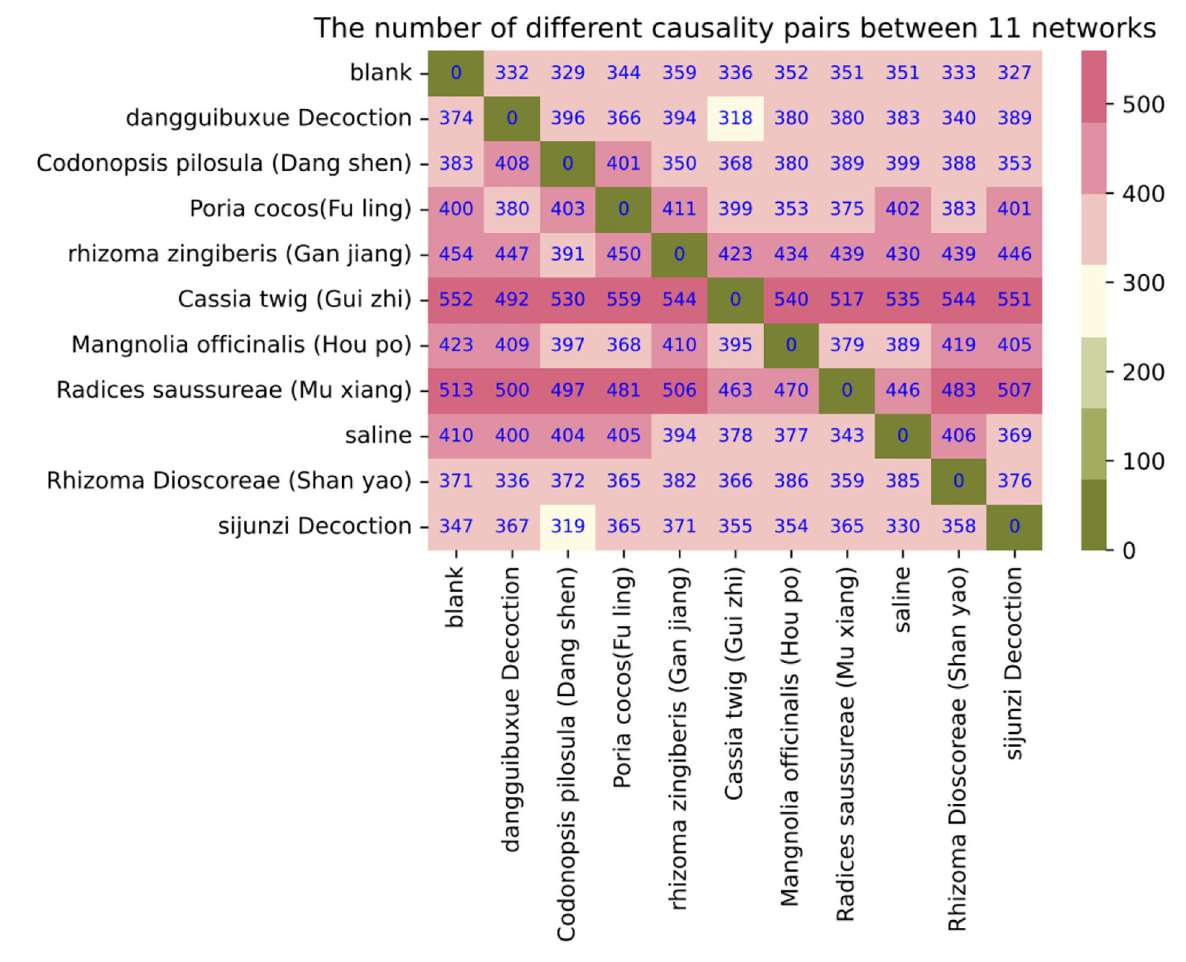
FIGURE5 The number of different causality pairs among the 11 Granger causality